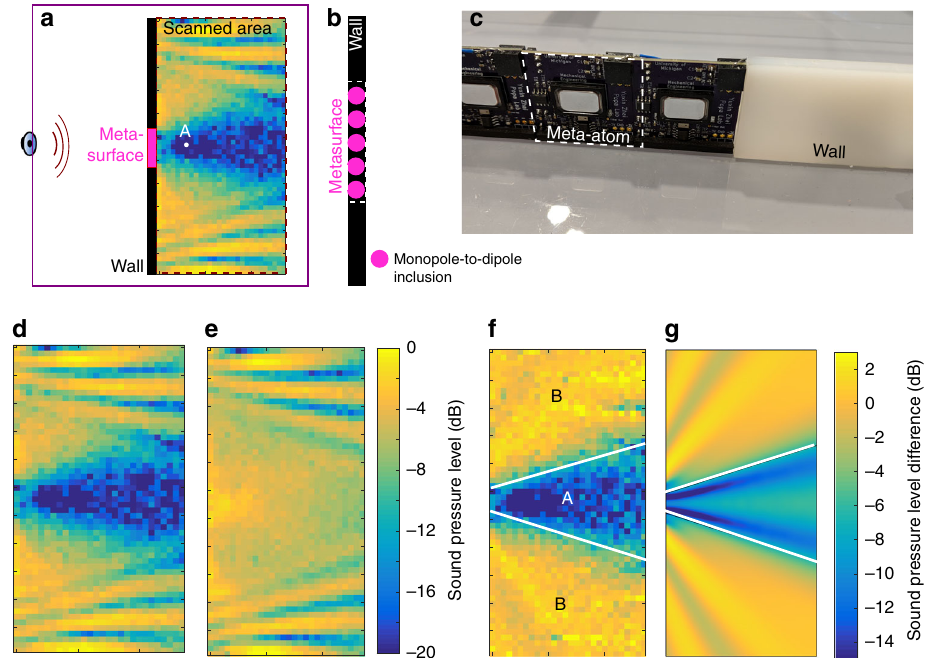
Fig. 3 Experimental setup and performance. a A speaker placed on the edge of a two-dimensional acoustic waveguide sends acoustic waves inside the waveguide towards a polycarbonate wall 6 mm thick. The bianisotropic metasurface replaces a wall section 17.5 cm long in the middle of the wall. The sound pressure distribution is measured in a 110 cm by 50 cm region placed immediately behind the wall. The region shows the measured sound pressure level at 3000 Hz obtained with the activated metasurface. Point A is situated 10 cm behind the metasurface. b The metasurface is composed of fi ve meta- atoms placed side by side. Each meta-atom simulates a monopole-to-dipole inclusion embedded into the polycarbonate wall. c Photo of metasurface and wall. The monopole-to-dipole meta-atom is highlighted. d Sound pressure level (SPL) measured at 3000 Hz with the bianisotropic response activated ( α md ≠ 0) and e deactivated ( α md = 0). f SPL difference between the activated and deactivated states. The sound suppression level (SSL) is de fi ned as the difference between the average SSLs computed in regions A and B. g Numerically simulated SPL difference for an in fi nitely stiff and dense wall